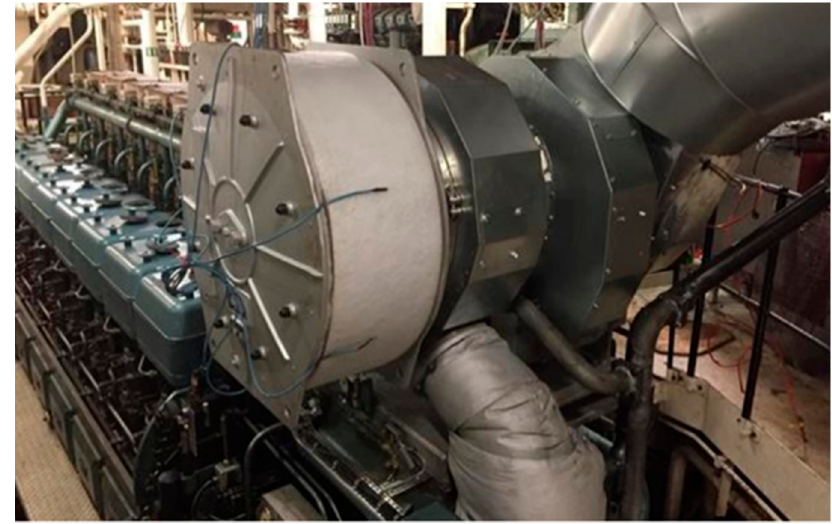
Figure 1. The turbocharger of two-stroke marine engine (MAN, TCR 18) [18] .